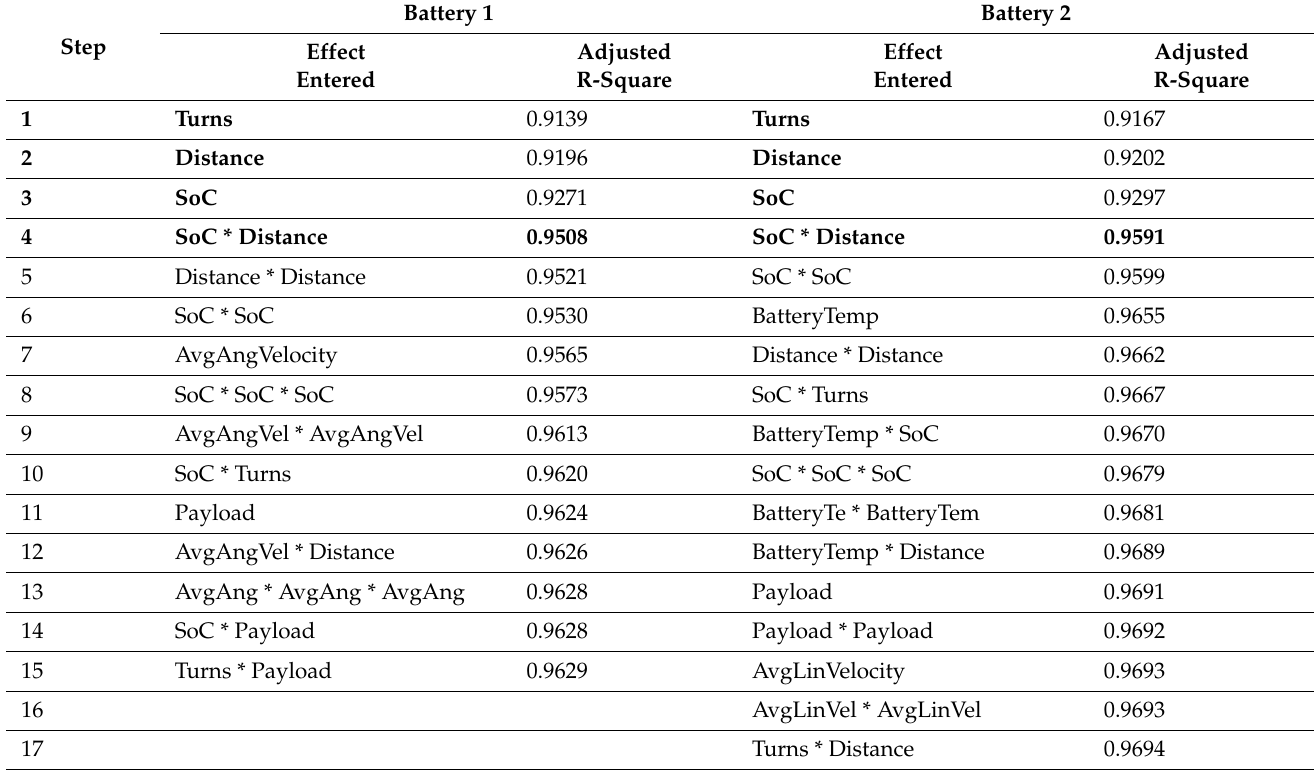
Table 5. Effects introduced in the consecutive steps of the forward selection algorithm for both of the tested batteries.